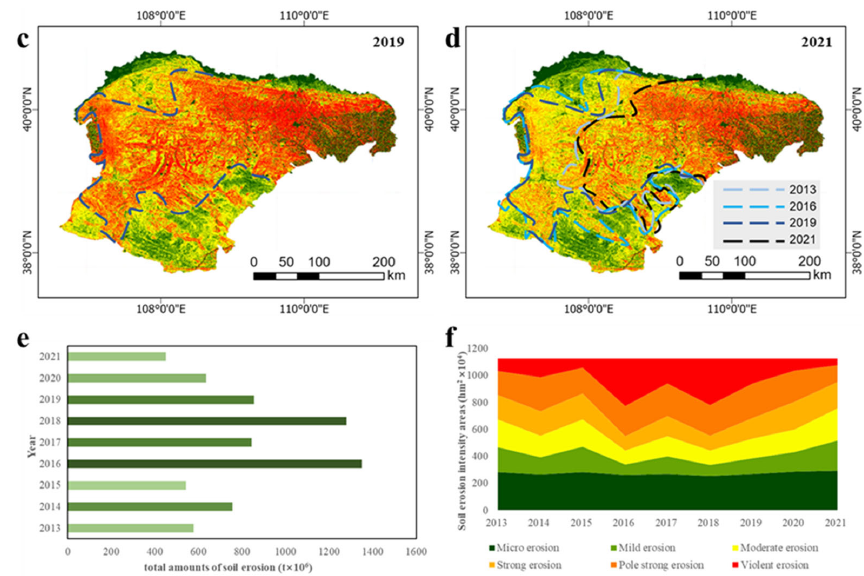
Figure 4. Changes in erosion strength. ( a – d ) are in erosion in 2013, 2016, 2019, and 2021, respectively. The dotted line indicates the approximate dividing line between mild erosion and strong erosion. ( e ) Total amounts of soil erosion from 2013 to 2021. ( f ) Stacked chart of different types of erosion from 2013 to 2021.